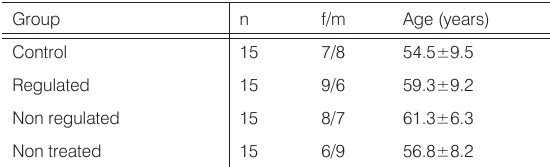
Table 1. Gender and age in investigated groups.